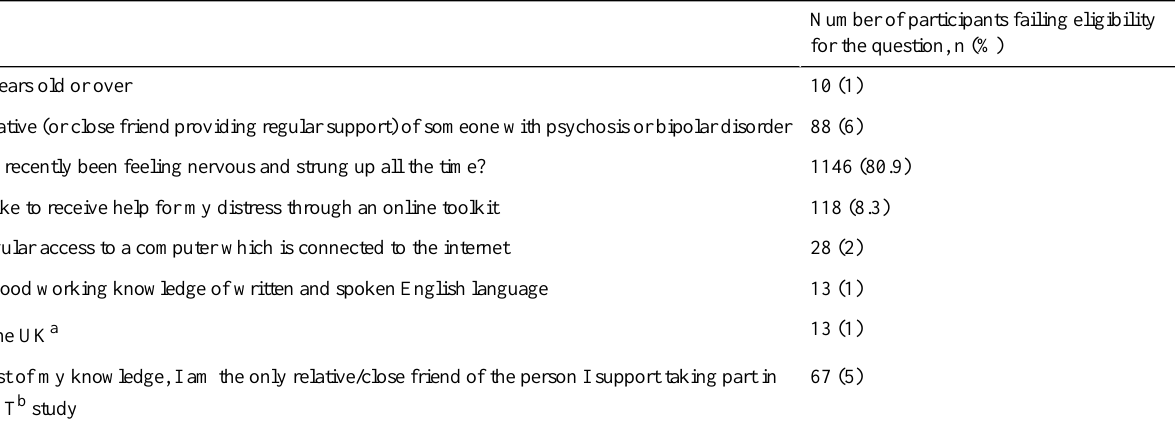
Table 3. Eligibility